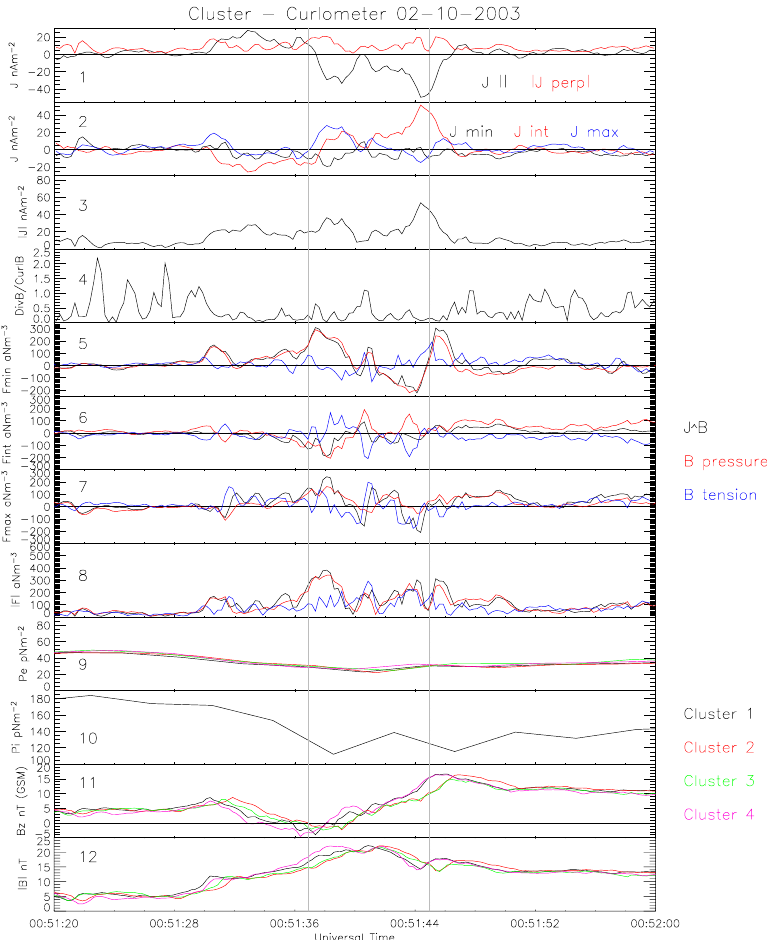
Fig. 8. Cluster curlometer observations of 2 October 2003. Panel 1 shows the current parallel (black) and the magnitude of the current perpendicular (red) to the magnetic field. Panel 2 shows the current projected into the minimum (black), intermediate (red) and maximum (blue) variance directions respectively. Panels 3 and 4 show the magnitude of the current and the fractional error in the curlometer result respectively. Panels 5 to 7 show J × B (black), magnetic pressure (red) and magnetic tension (blue) projected onto the minimum, intermediate and maximum variance directions of Cluster 1 respectively. Panel 8 shows | J × B | and the magnitudes of the magnetic pressure and tension forces. Panels 9 and 10 show the electron and ion pressure respectively, with the final two panels showing the B Z and | B | observations displaying the bipolar signature and increase in | B |